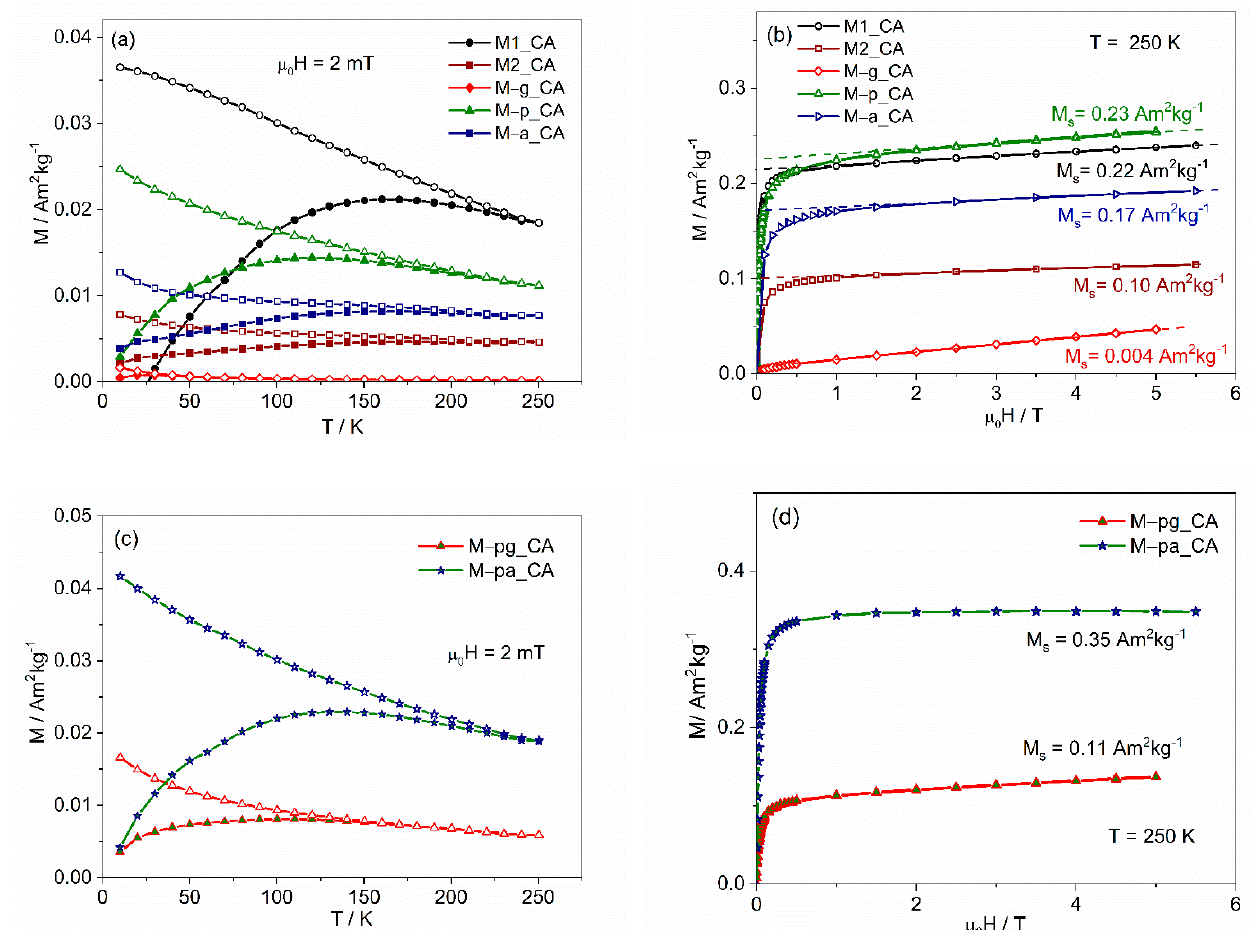
Figure 11. Magnetization results for the ferrofluids: ( a , c ) temperature dependence after zero-field cooling (ZFC) (full symbols) and after cooling under the measuring field of 2 mT (FC) (open symbols); ( b , d ) isothermal magnetization curves at 250 K.